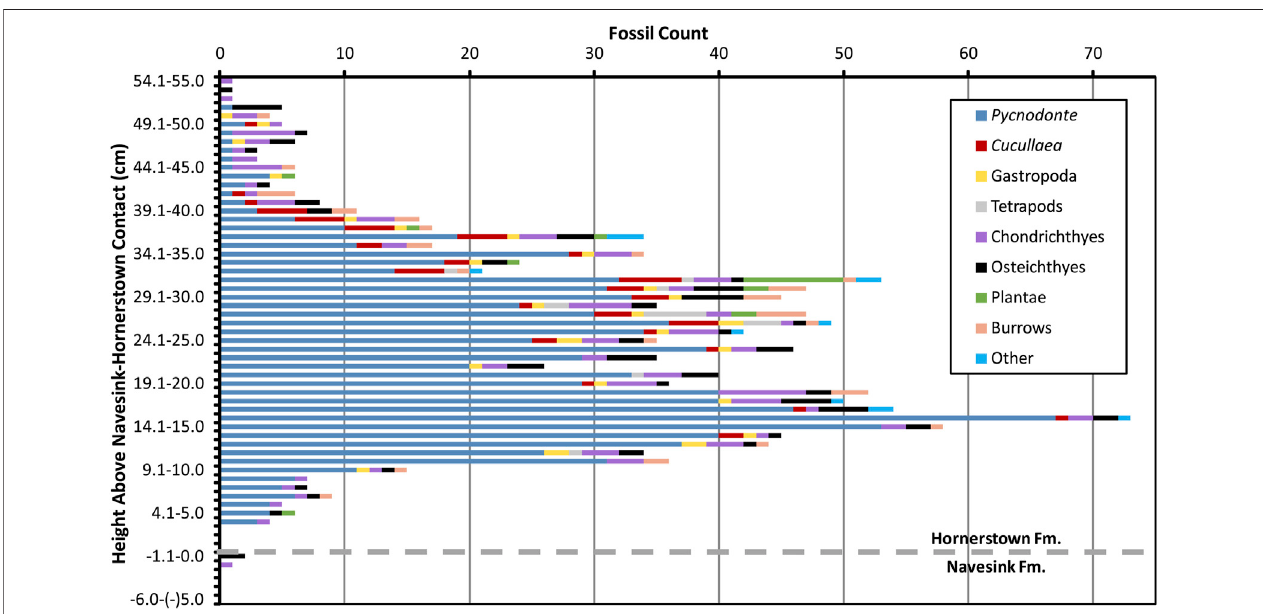
FIGURE 2 | Stacked bar graph of fossil abundances per 1 cm stratigraphic bin, color-coded by taxonomic category as shown in the legend. Dashed gray line is positioned at the contact between the Navesink and Hornerstown formations.